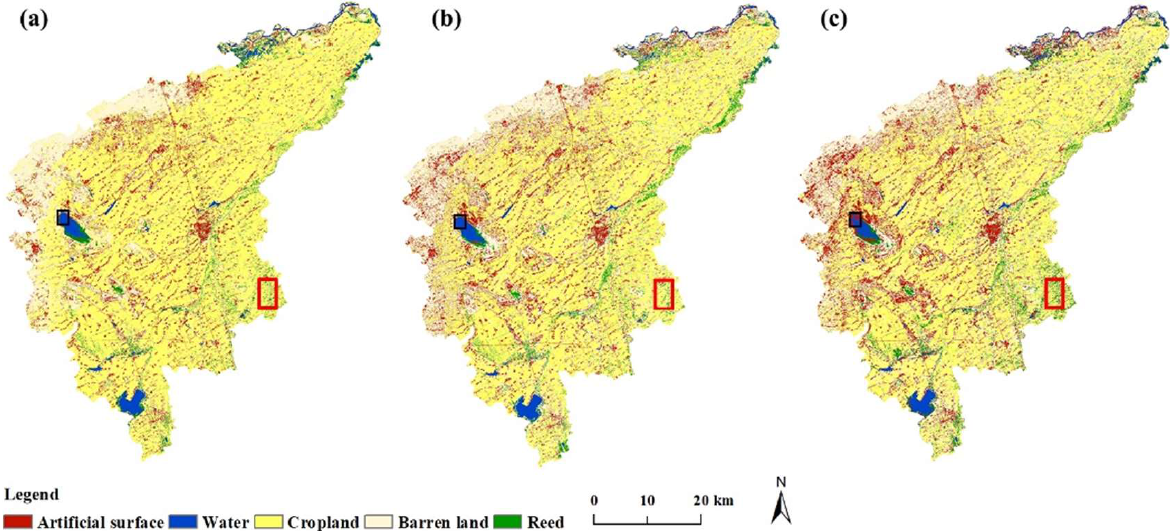
Figure 3. Habitat classification results. ( a ) SVM; ( b ) RF; ( c ) ML. Table 3. Overall accuracy and kappa coefficient of the three classification methods. Evaluation Index